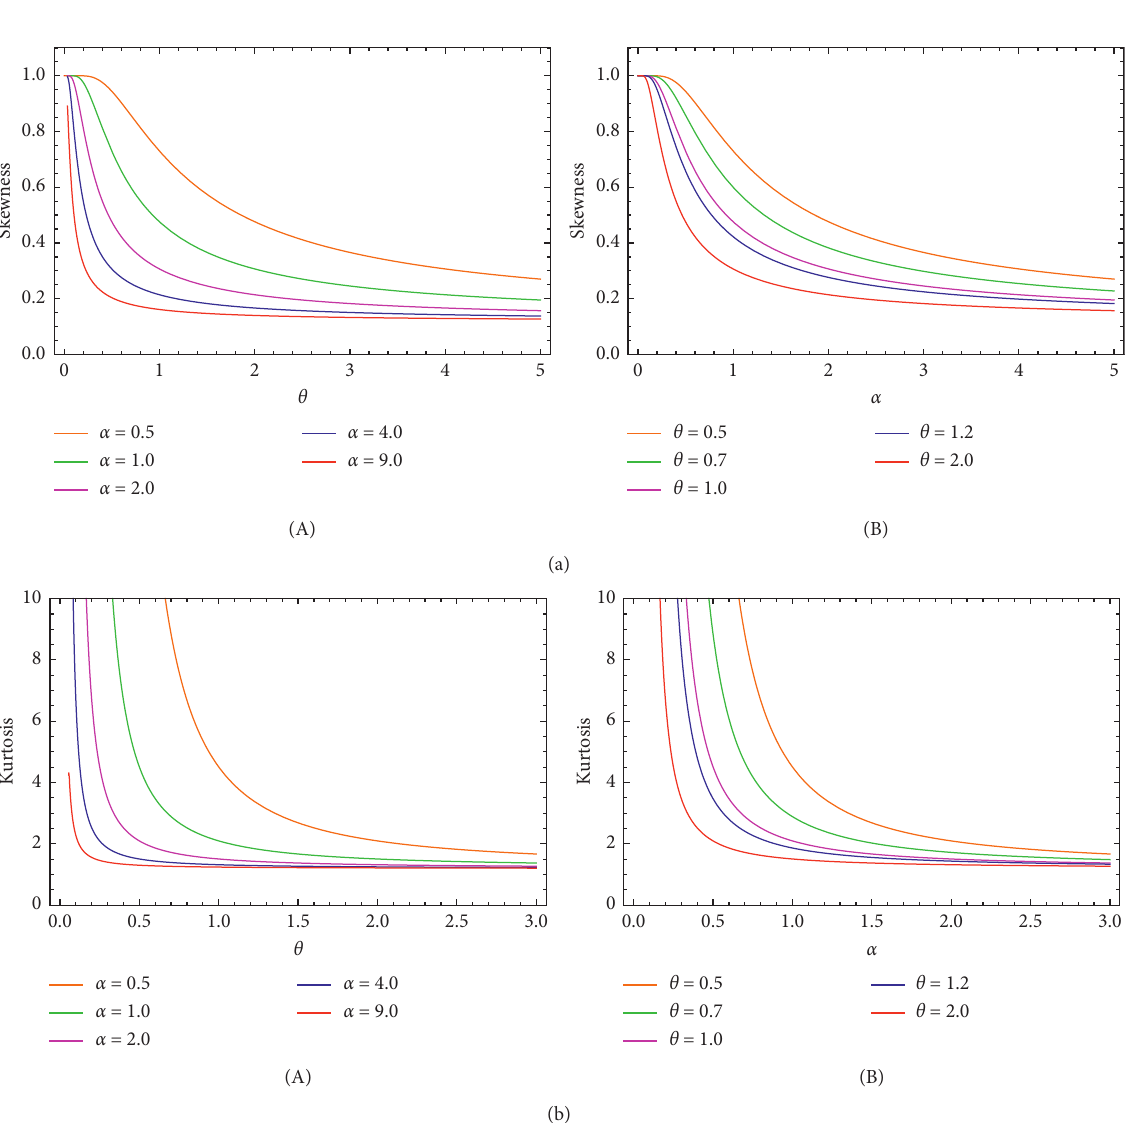
Figure 2: (a) Skewness of the OFIL distribution: (A) as a function of θ for certain values of α ; (B) as a function of α for certain values of θ . (b) Kurtosis of the OFIL distribution: (A) as a function of θ for certain values of α ; (B) as a function of α for certain values of θ